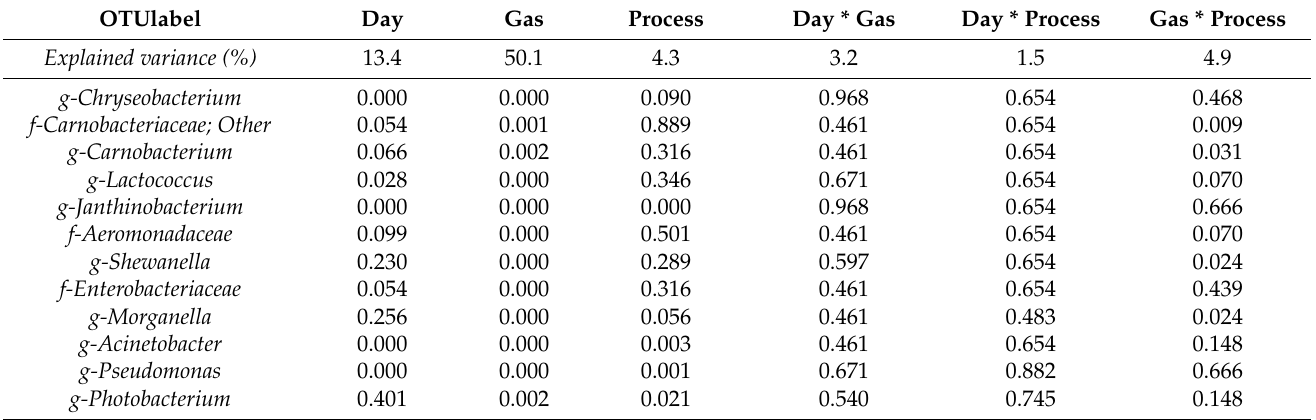
Table A4. 5050 manova results for bacteriota. The table shows the false discovery rate (FDR) adjusted p -values and the explained variance for each of the terms included in the model. The "*" is showing the interactions.